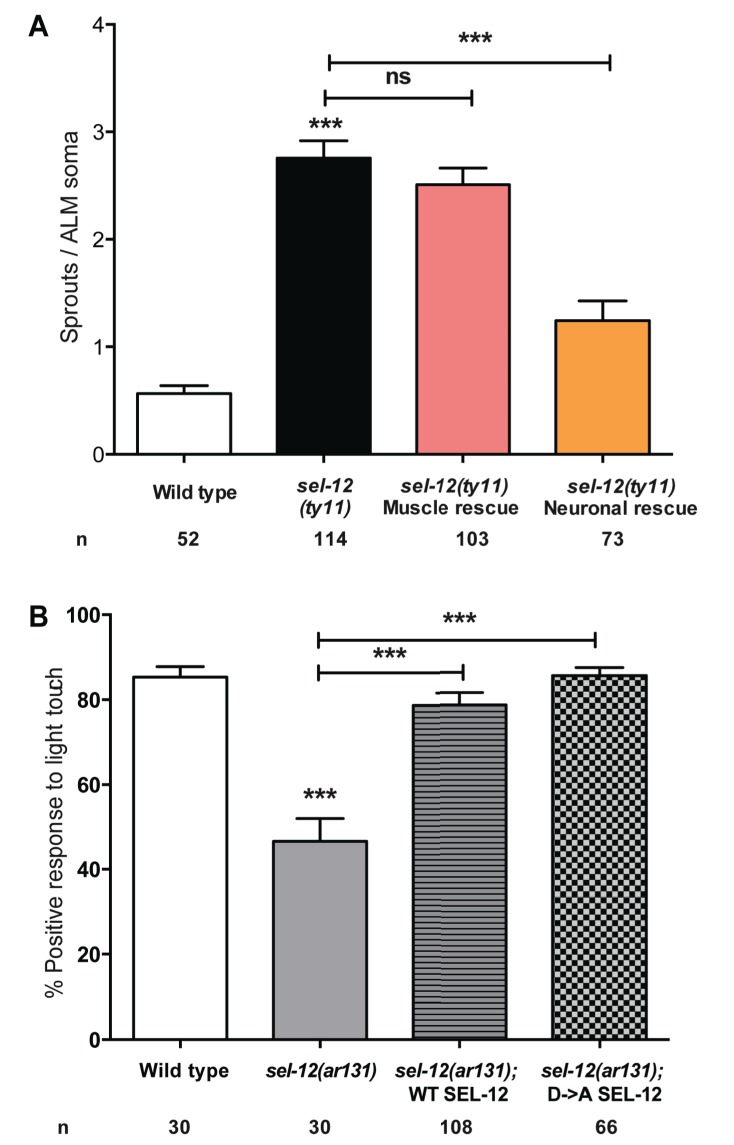
SEL-12 has a tissue-specific but protease independent role in neuronal health maintenance.(A) Quantification of aberrant structures (sprouts/branches) in ALM neurons of day one sel-12(ty11) animals with tissue specific SEL-12 expression. ALM neuronal morphology analysis is done using transgenic animals expressing mec-4p::GFP (zdIs5). (B) Quantification of the response of wild type, sel-12(ar131) and sel-12(ar131) animals expressing wild type or a protease dead SEL-12 to anterior and posterior light touches. n = number of animals analyzed per genotype. Data are displayed as mean ± SEM, and all comparisons have been made to wild type animals unless otherwise indicated. ns p>0.05, ***p<0.0001 (One way ANOVA with Tukey test).10.7554/eLife.33052.008Figure 3—figure supplement 1—source data 1.Raw data for Figure 3—figure supplement 1.